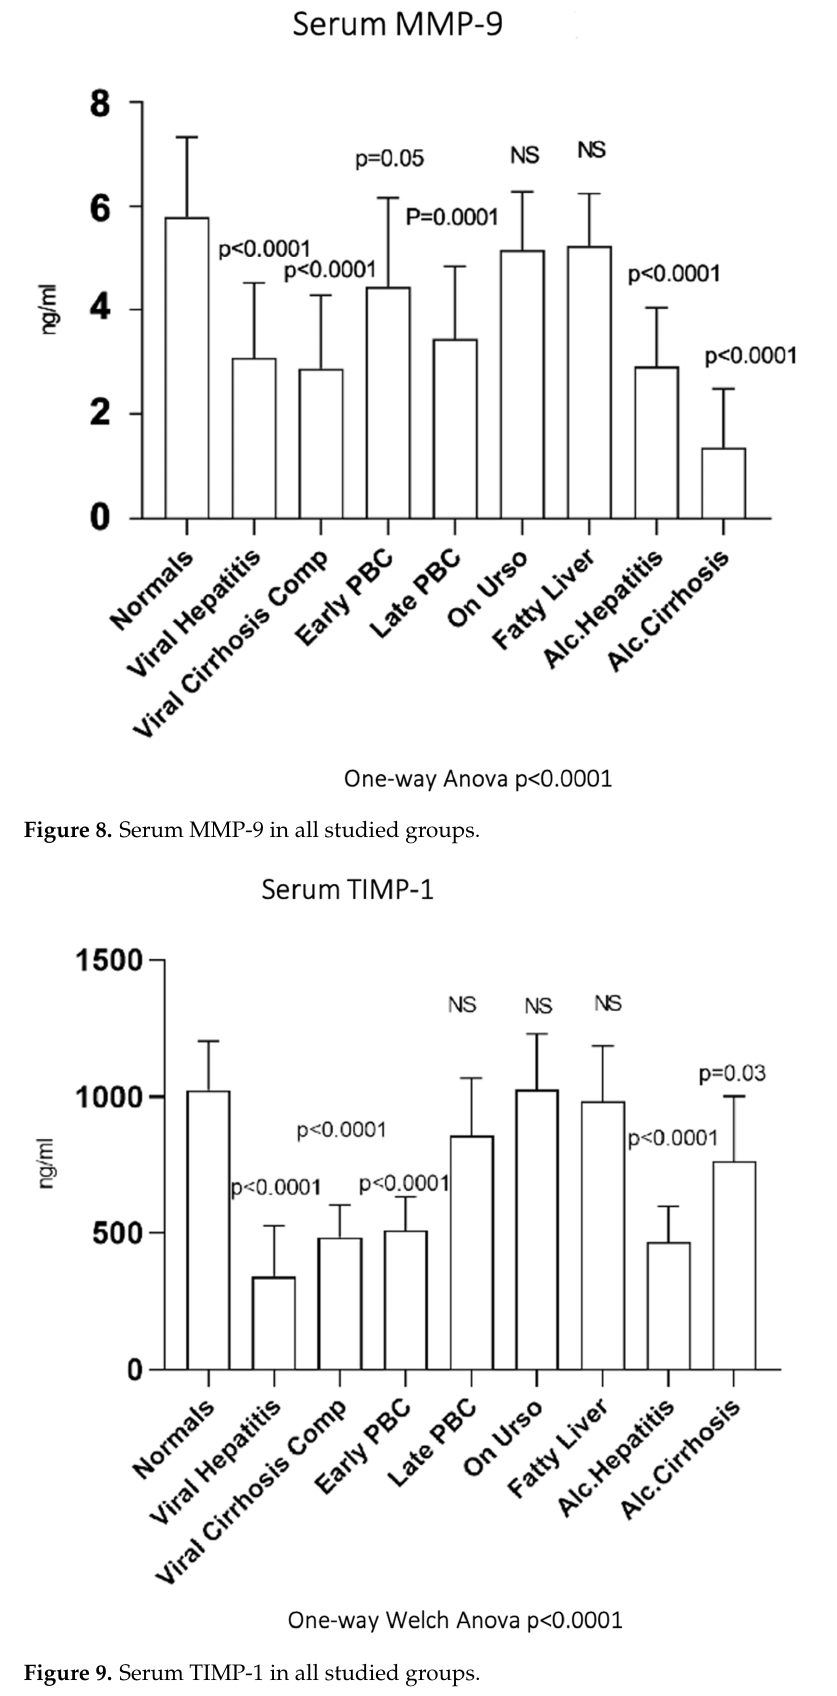
Figure 9. Serum TIMP-1 in all studied groups.